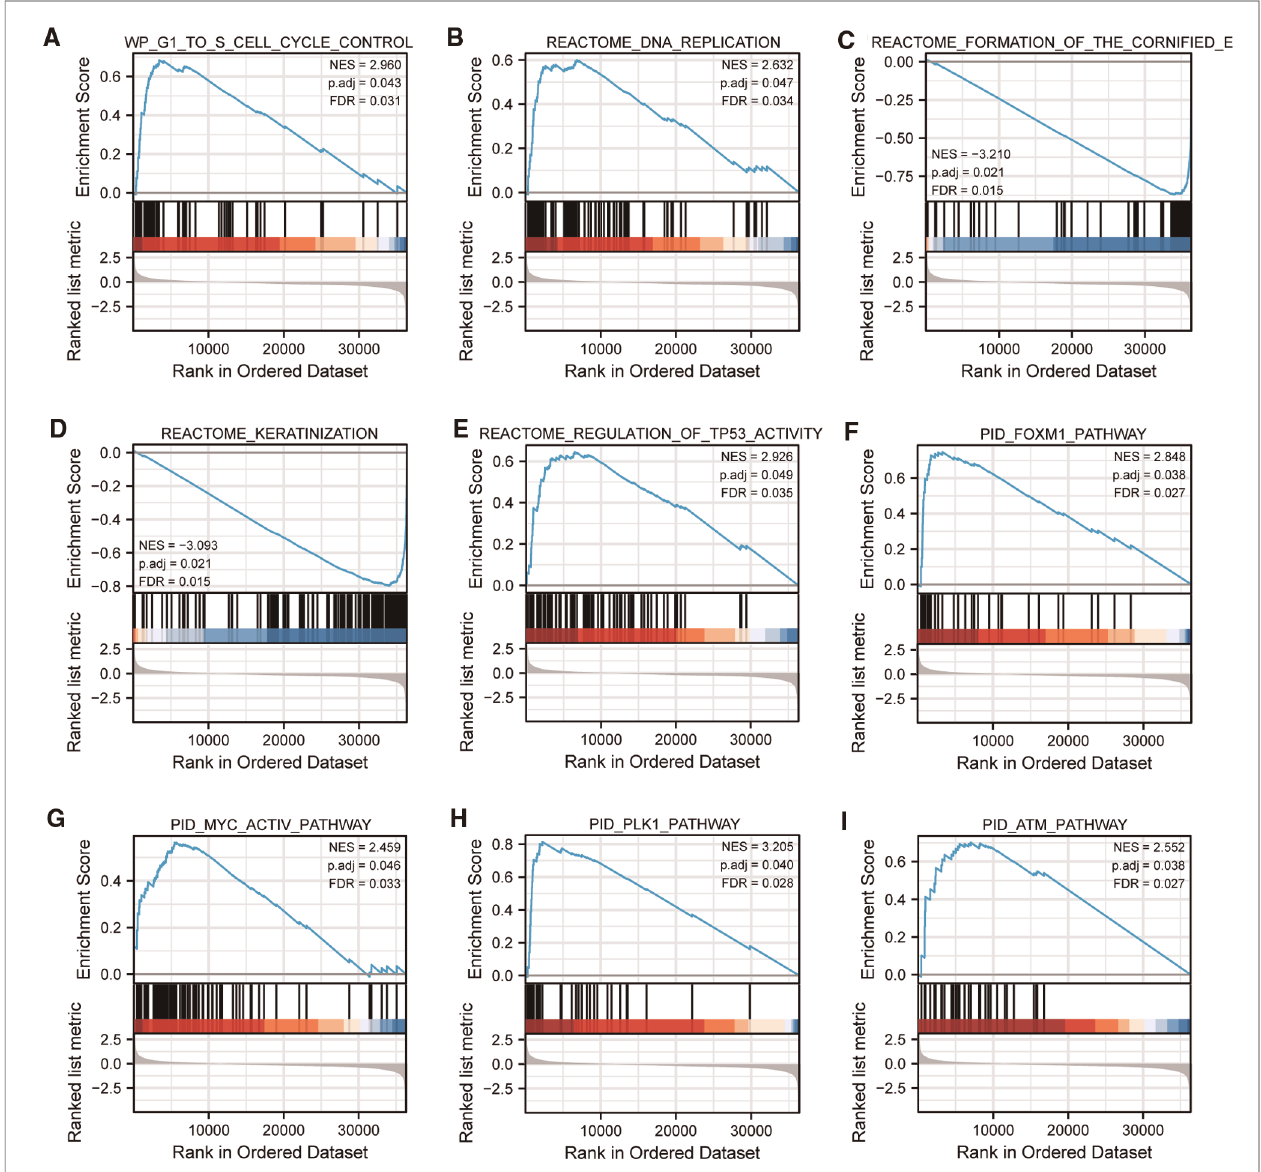
FIGURE 3 | Representative GSEA enrichment plots of DEGs between high- and low-TIM expression groups. ( A – I ) NES, normalized enrichment score; p .adj, adjusted p -value; FDR, false discovery